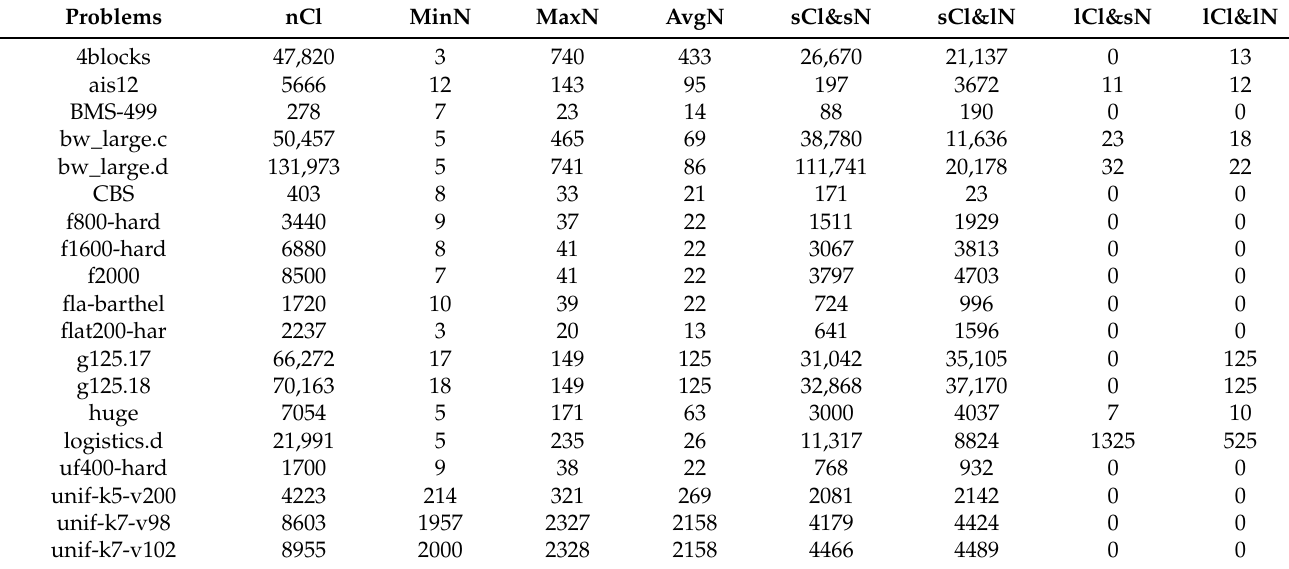
Table 1. General structural statistics of each problem in our problem